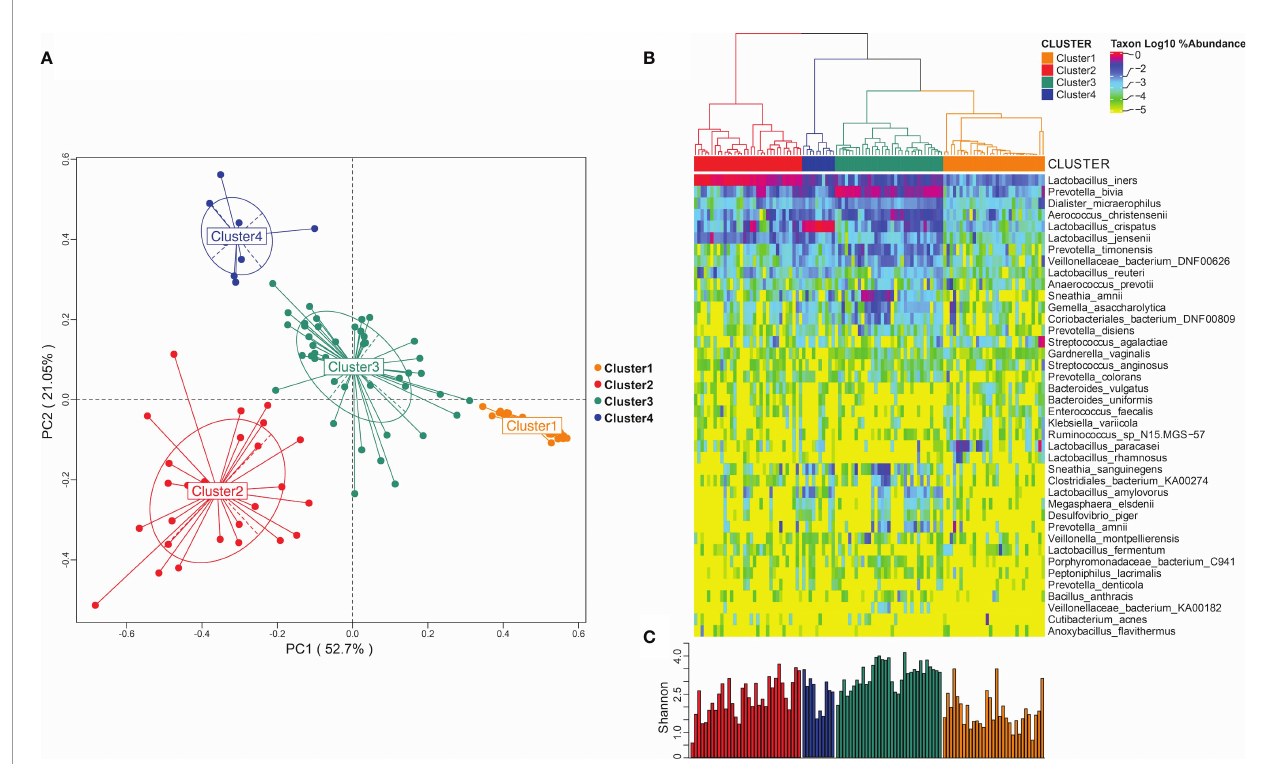
FIGURE 1 | Microbiome of vaginal bacterial community. (A) Microbiome distribution obtained by PCoA clustering of the vaginal microbiota of all subjects; (B) heat maps of vaginal microbiome abundance distribution and the distribution of microbial community obtained by hierarchical clustering. (C) Shannon diversity index distribution in different microbial